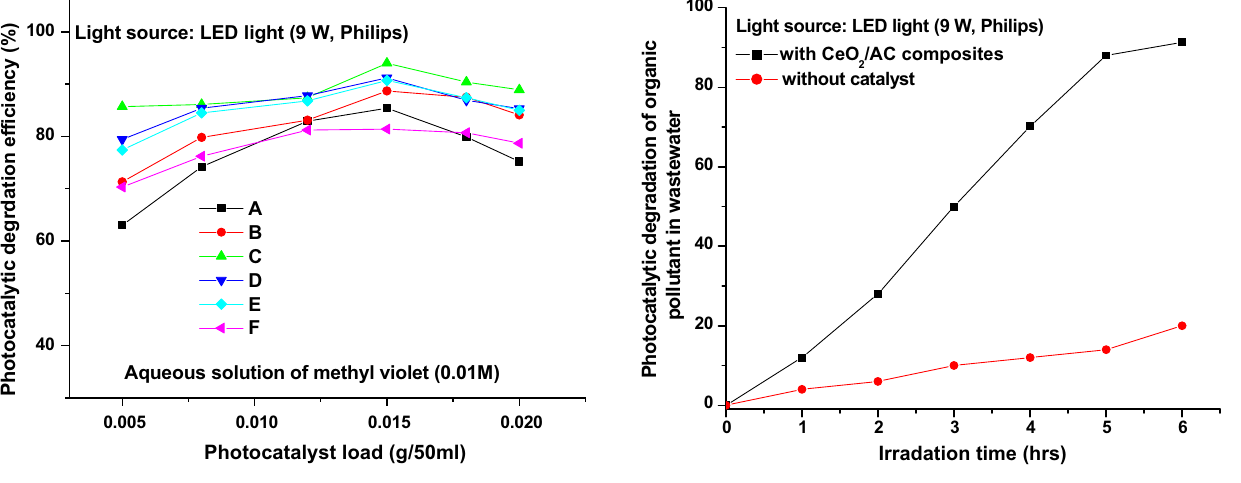
Fig. 11 Photocatalytic degradation of organic pollutants and dyes in textile industrial wastewater using CeO 2 /AC (3:2)